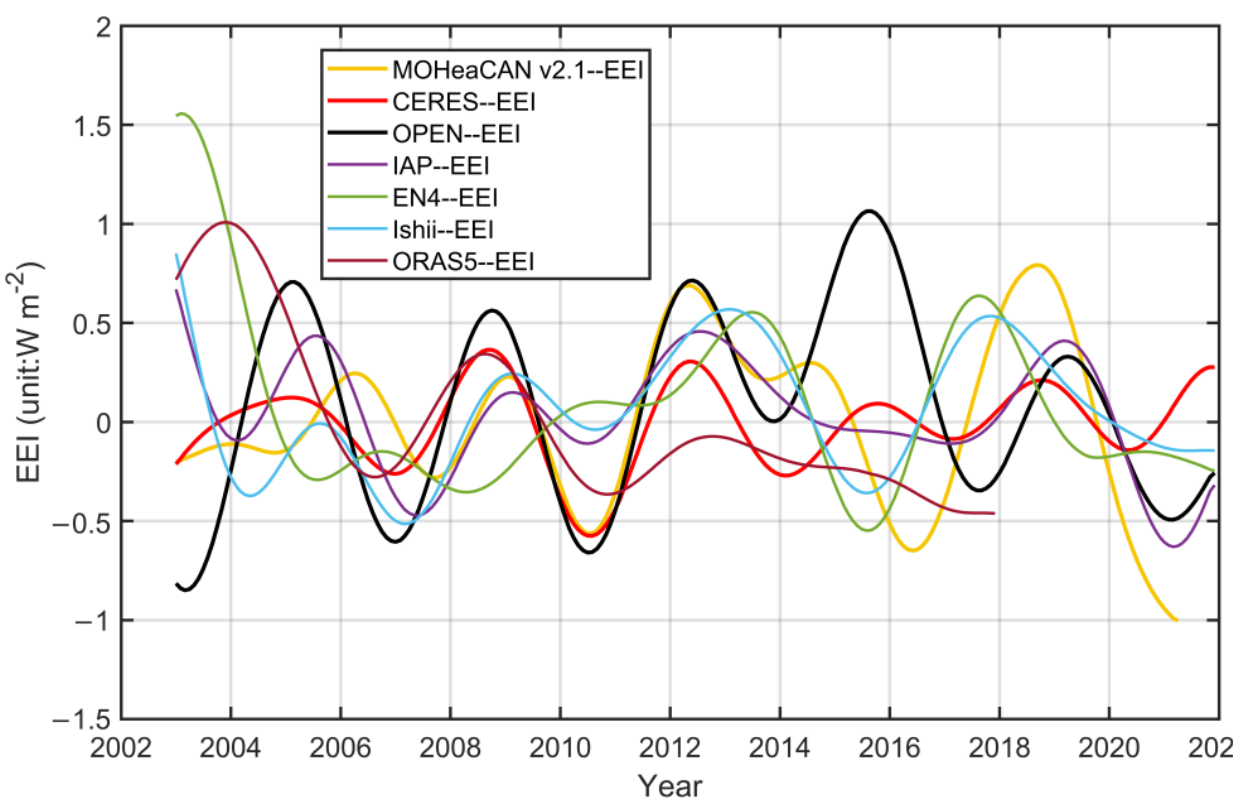
Figure 4. Interannual variations of Earth’s energy imbalance (EEI) (unit: W m − 2 ) over the January 2003–December 2021 period. Trends and means are removed in advance, while the time series data is filtered by a low-pass filter at 3 years to highlight interannual signals. Different colored lines correspond to estimates for different datasets.